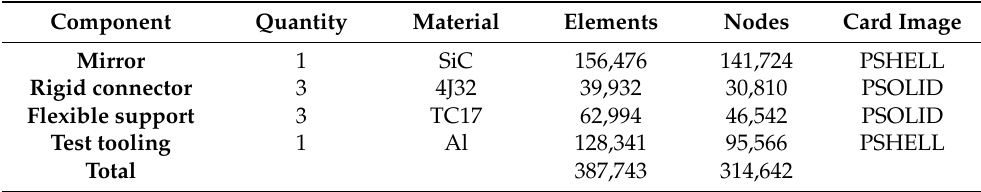
Figure 7. Design route in ISIGHT software.